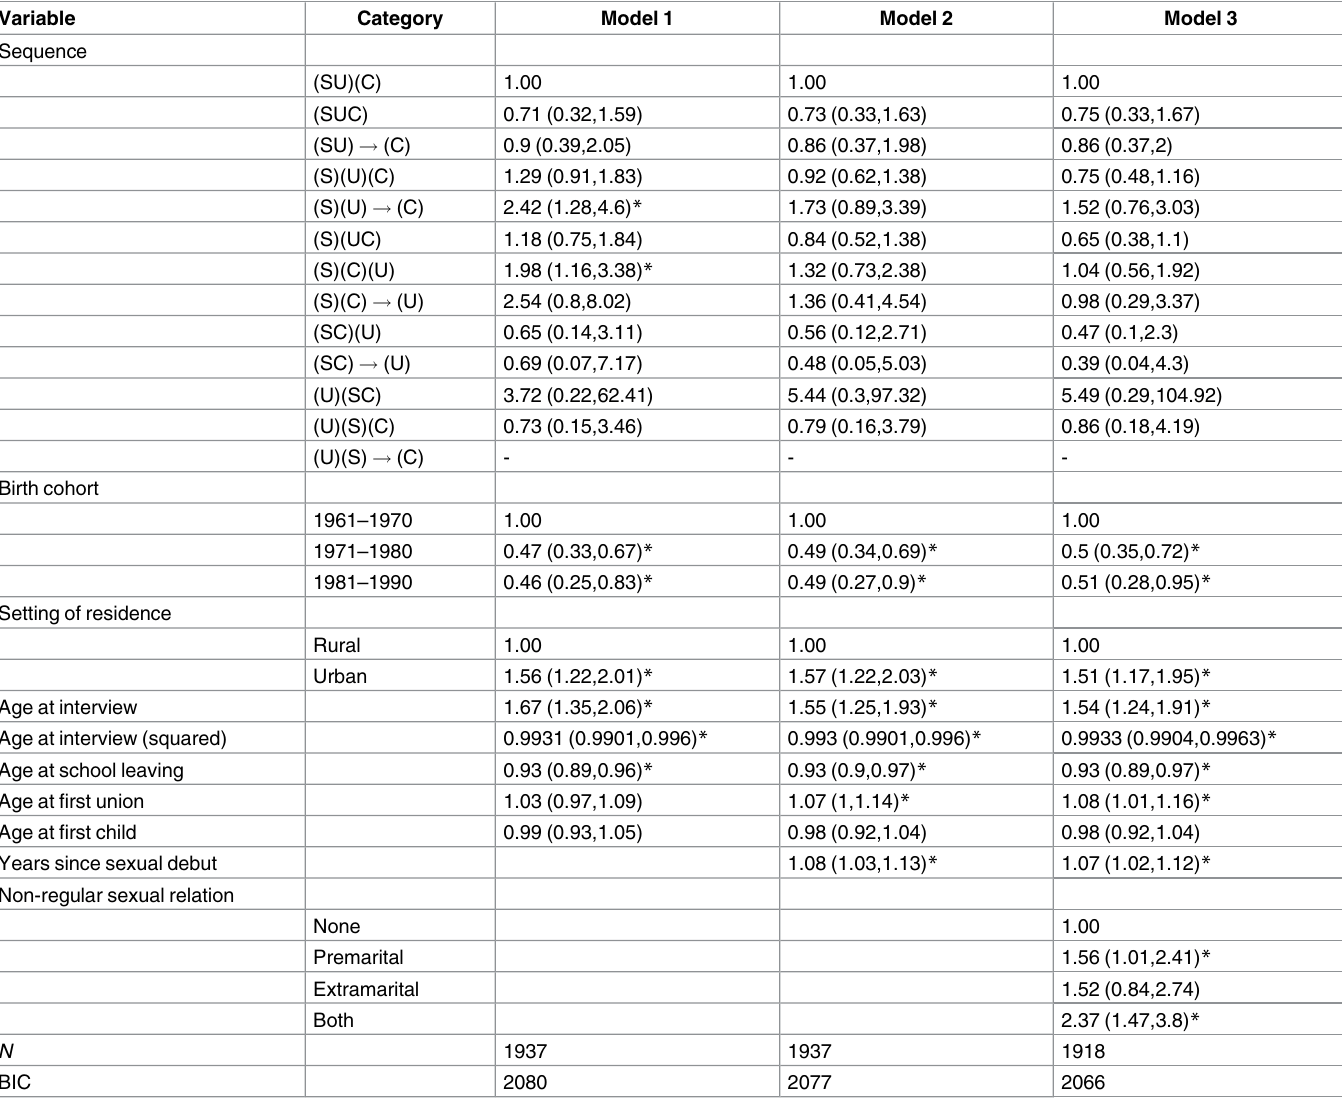
Table 4. Adjusted prevalence odds ratios for men. Adjusted odds ratios and 95% confidence intervals for the probability of being HIV-infected, based on logistic regressionmodels, among men, Manicaland(Zimbabwe), 2000–2011. Sample size is varying because of missing values.